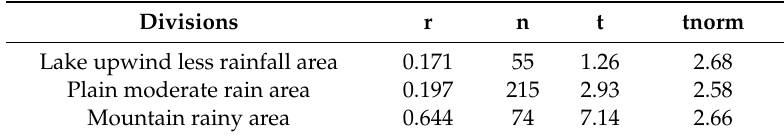
Table 3. Correlation coefficient between precipitation spatial distribution of different EOF-1 divisions